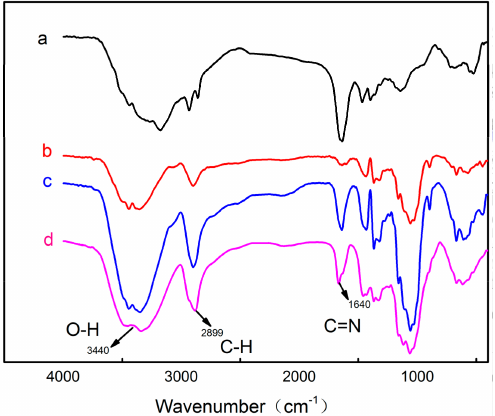
Figure 1. FTIR spectra of ( a ) PHGH; ( b ) SBC; ( c ) P-SBC and ( d )